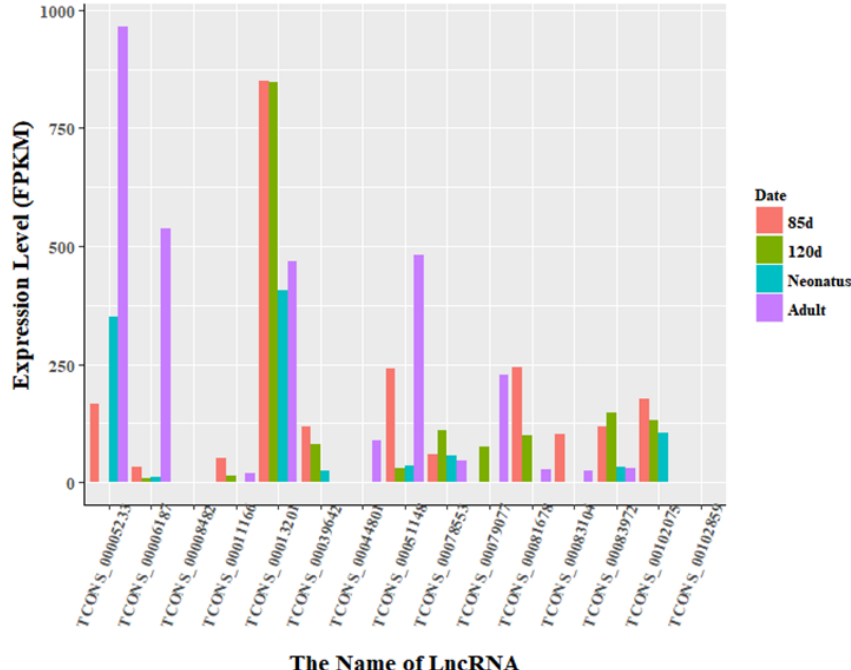
Figure 7. Expression level of differentially expressed lncRNAs at all stages in Ujumqin. There were 15 lncRNAs that were identified to be differentially expressed in all stages. The expression levels of lncRNA transcripts were estimated using FPKM. In particular, the expression of TCONS_00006187 was markedly higher in adult Ujumqin sheep than at other stages. Moreover, TCONS_00013201 was highly expressed at all stages in Ujumqin sheep, while the expression level of TCONS_00083104 in Texel 85-day-old fetus and adult was low. TCONS_00044801 was expressed only in Ujumqin adult, while TCONS_00008482 and TCONS_00102859 were not expressed at all in Ujumqin sheep. These six lncRNAs showed different expression from that in Texel sheep.